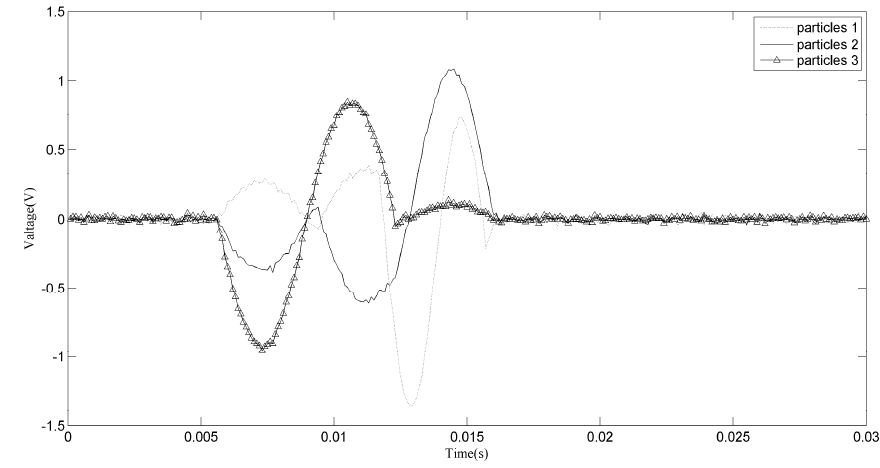
Figure 15. Demixing result of section a2.